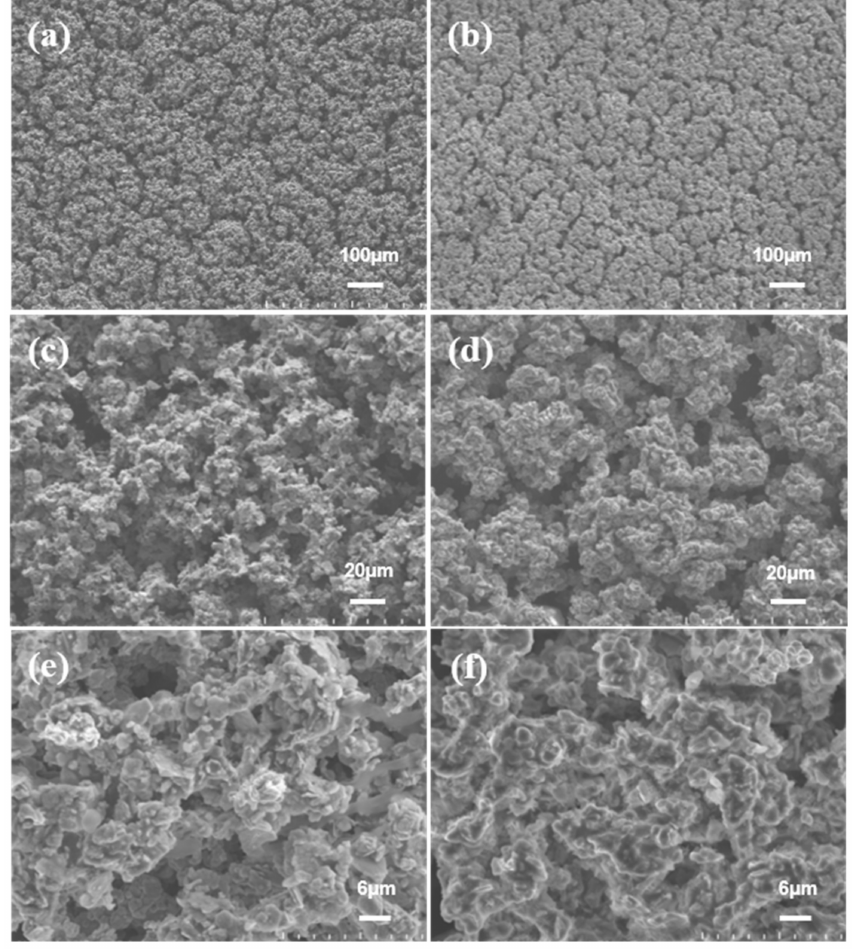
Figure 10. SEM images of the Ni-Co/WS 2 nanocomposite coatings prepared by PC ( a , c , e ) and DC ( b , d , f ). The magnification was 500 times, 1000 times, and 1500 times for the first, second, and third rows,